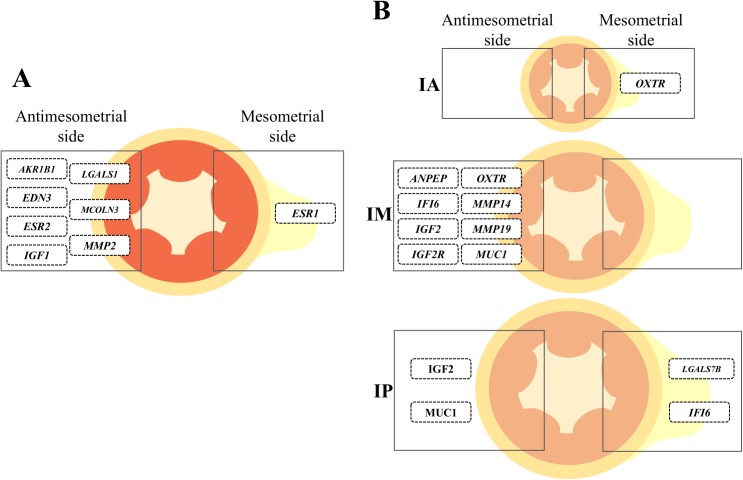
Summary of side-dependent differences in gene expression.Schematic representation of distribution of genes affected by Side (antimesometrial vs. mesometrial; Panel A) and by the Side by Region (IA, anterior; IM, medial; IP, posterior; Panel B) interaction in the uterine horn ipsilateral to the CL. The position of each differentially expressed gene in the figure indicate an upregulation in the side.